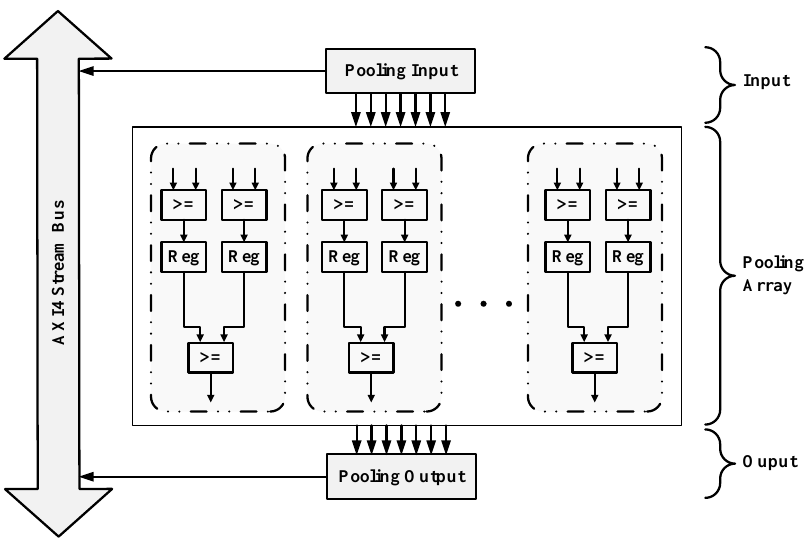
Figure 14. Pooling acceleration module.